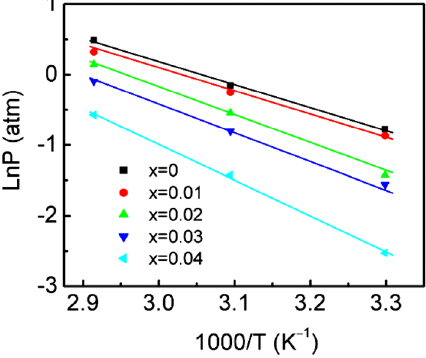
Fig. 7 Cycle life curves of the Re ( x = 0 ‒ 0.04) 2 Mg(Ni 0.7 − x Co 0